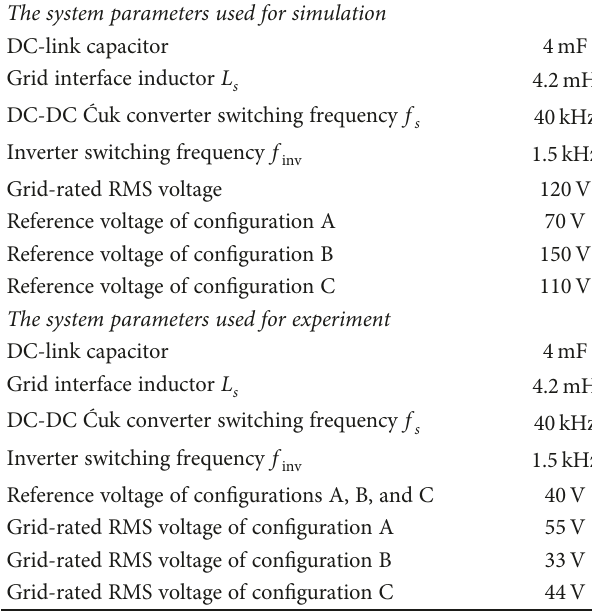
Table 1: The system parameter.